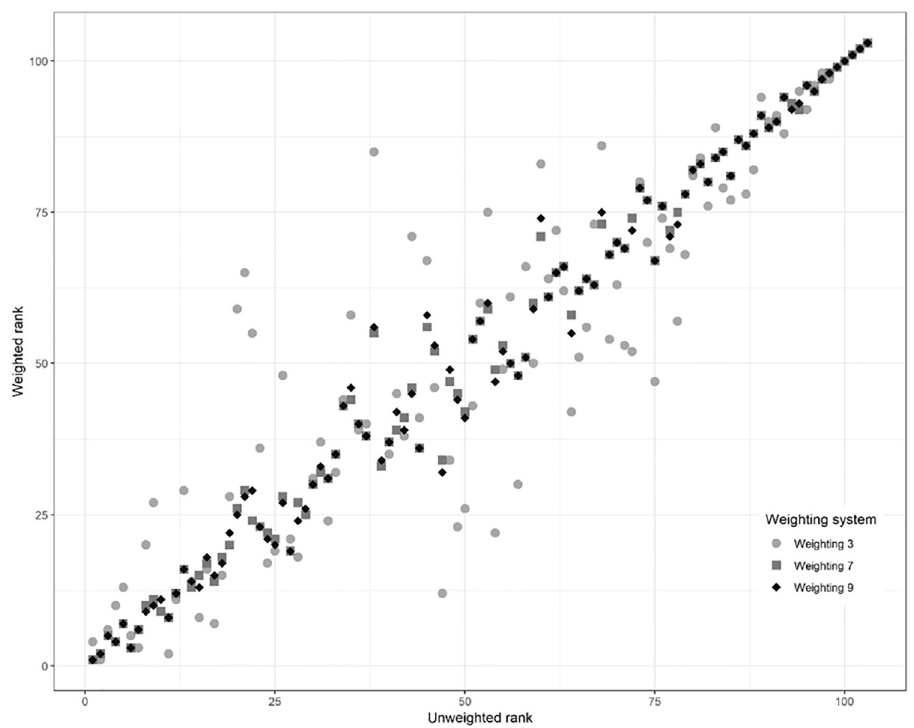
Fig 4. Relationship between unweighted resilience ranks and select weighted resilience ranks for 103 sites around Puerto Rico. For descriptions of each weighting system, refer to Table 1. Root mean square error (RMSE): Weighting 3–14.2, Weighting 7–4.37, Weighting 9–4.85.